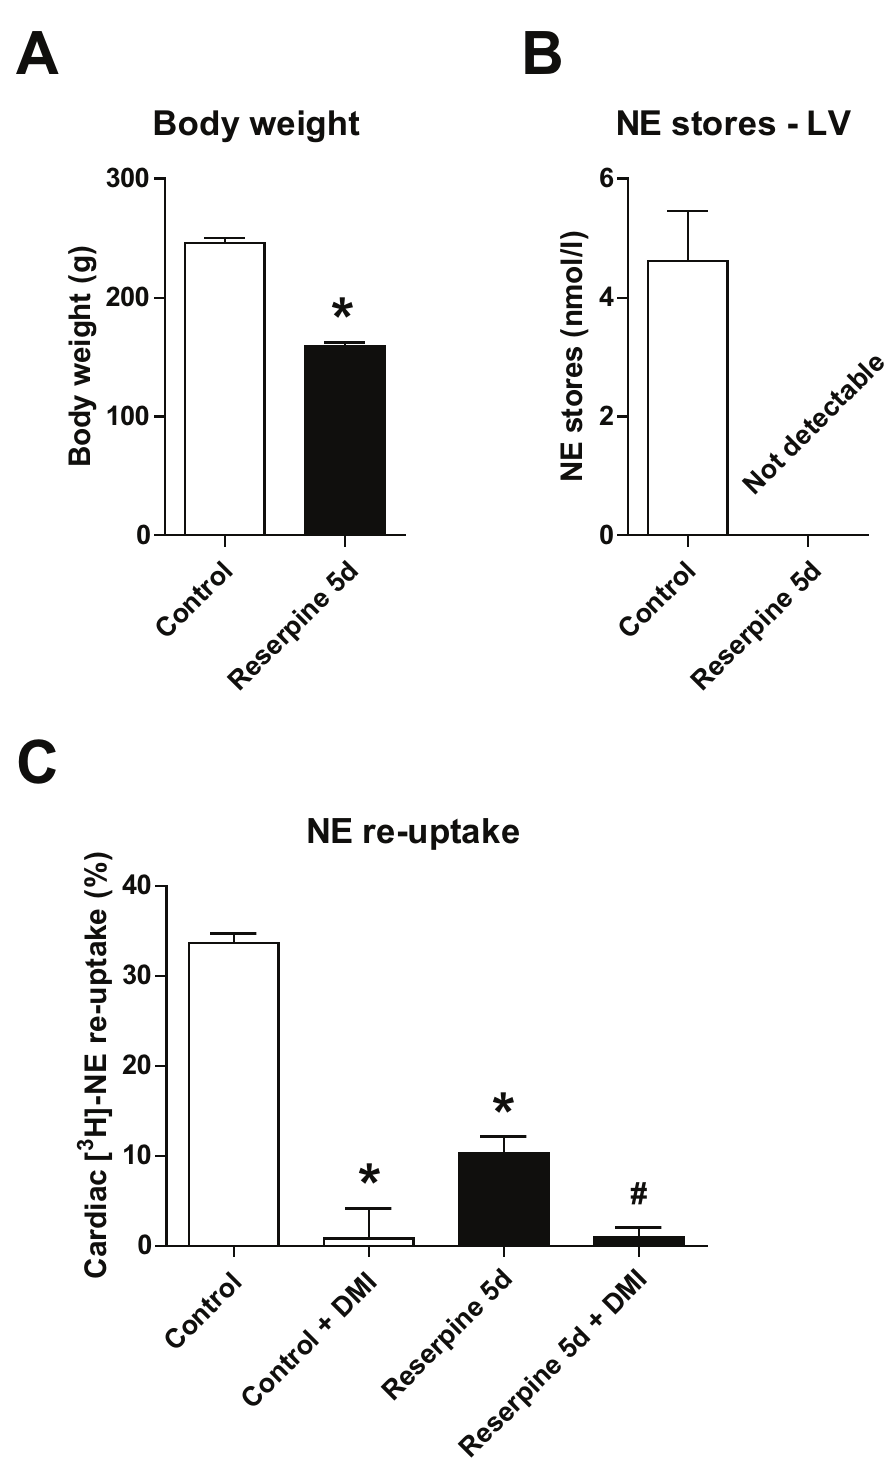
Fig 3. Cardiacnorepinephrine (NE) stores and NE re-uptakeafter five days (5d) of reserpinetreatment. (A) Body weightand (B) left ventricular (LV) NE content after five days of reserpine(5 mg/kg/d) or saline (control)treatment (n = 6 per group). (C) Cardiac[ 3 H]-NE uptakein the absenceor presenceof desipramine (DMI 1 μ mol/l)after five days of reserpinetreatment comparedto saline-treated controls(n = 6 per group). * p < 0.05vs. control, # p < 0.05vs.